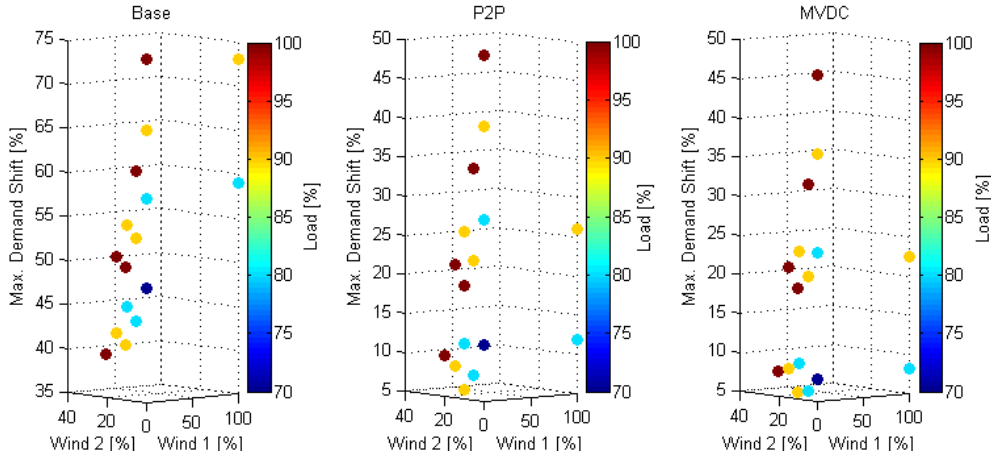
Figure 7. The comparison of maximum demand shift at different system configurations.